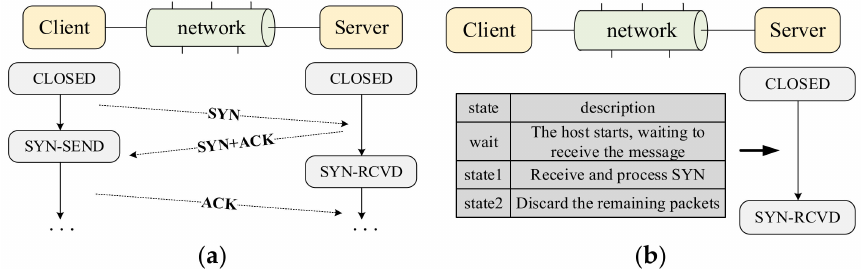
Figure 2. Comparison of the two states. ( a ) Schematic diagram of the global state. ( b ) Schematic diagram of the local